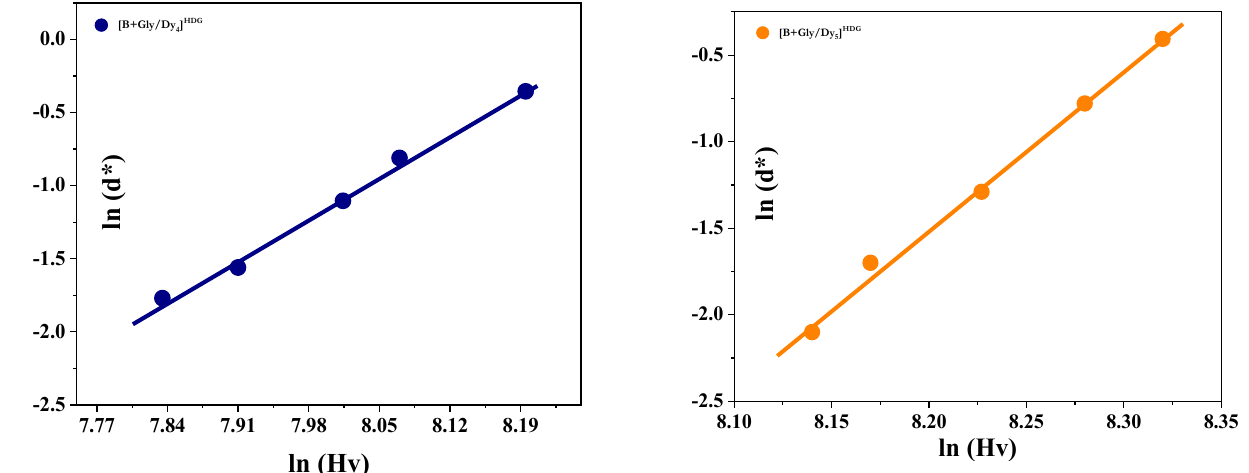
Figure 10. ln-ln of the Vickers hardness numbers against the dwell time of indentation at load 100 gf.